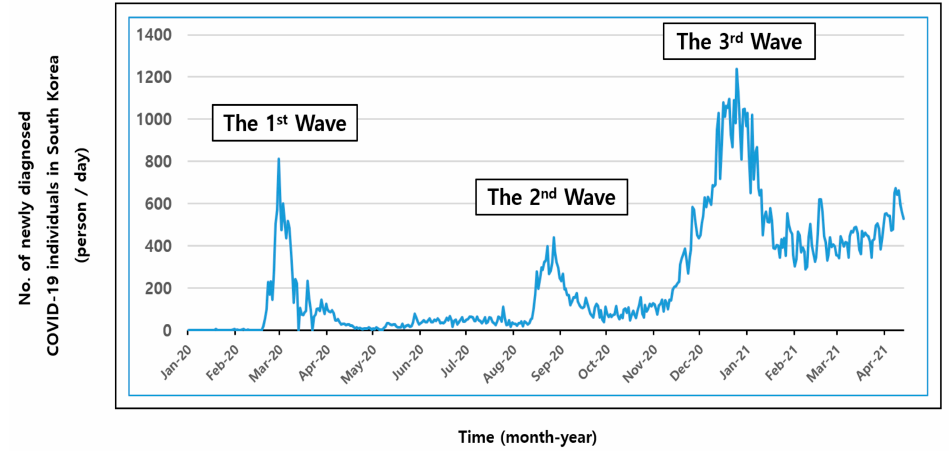
Figure 1. The number of newly diagnosed coronavirus disease 2019 (COVID-19) patients in South Korea (January 2020 to April 2021) shown in a chronological sequence. The number of newly diagnosed COVID-19 patients peaked in January 2020, February 2020, and April 2021. The 3rd wave of South Korea’s COVID-19 epidemic began in mid-December 2020 when 600 cases were reported and 1200 were confirmed by 25 December. From mid-January 2021, the number of newly confirmed cases reduced due to South Korea’s quarantine policies.